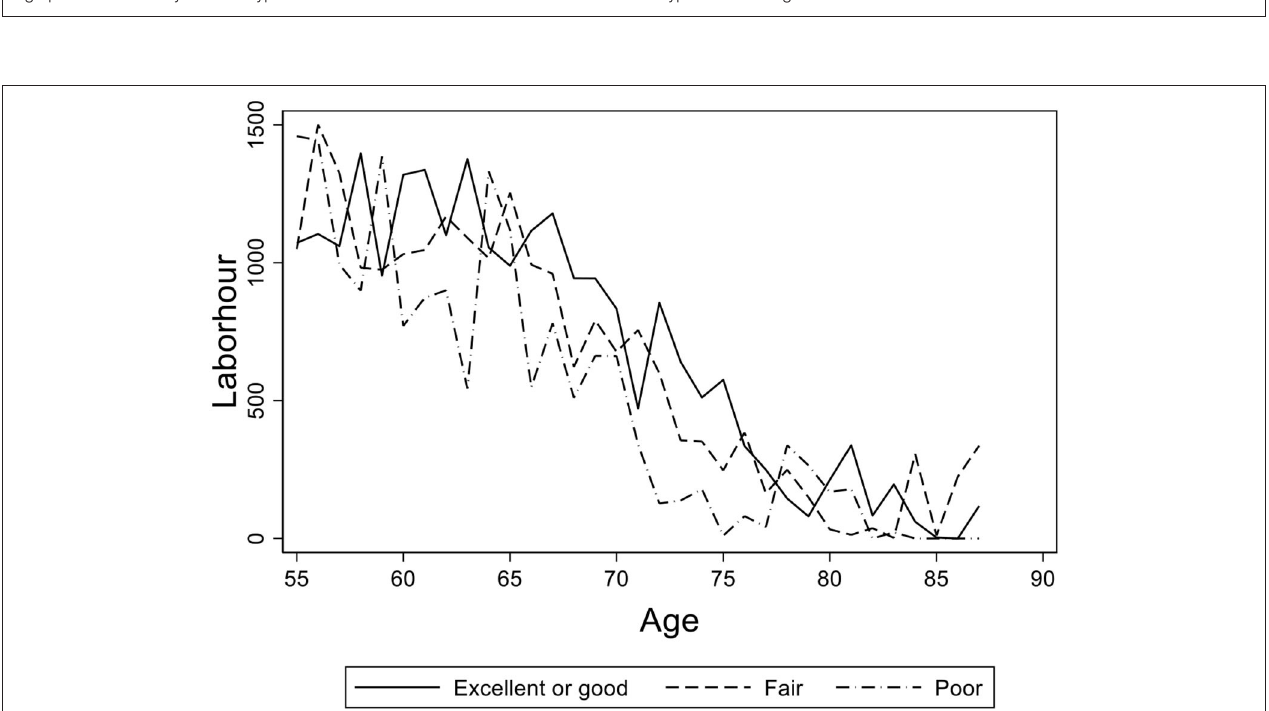
FIGURE 3 | The age distribution of average working hours for the elderly with different self-reported health statuses. Data from the China Health and Nutrition Survey (CHNS) database. The figure shows the age distribution of average working hours for the elderly with different self-reported health statuses in rural China. The solid line shows the age path of the elderly with “excellent” or “good” health, the dashed line shows the ones with “fair” health, and the dash-dotted line shows the ones with “poor” self-reported health status.